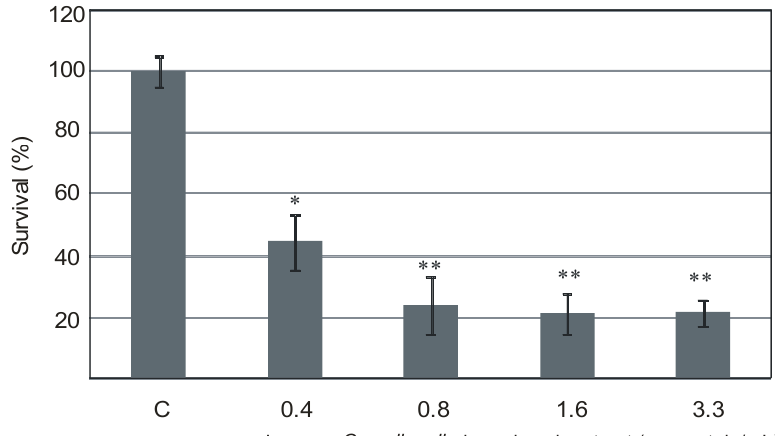
Figure 1. Growth inhibition of L. dumoffii by G. mellonella immune hemolymph